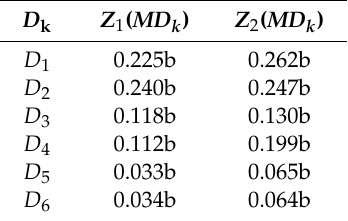
Table 3. Maximum data flow values under the initial state.